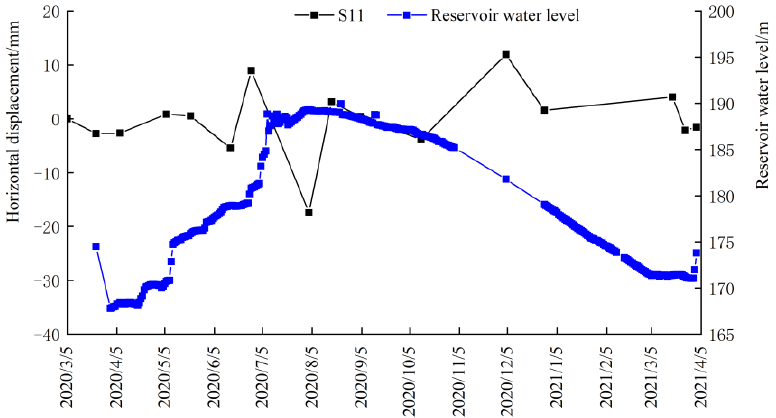
Figure 7. 1 # section horizontal displacement duration curve (upstream is − , downstream is +).